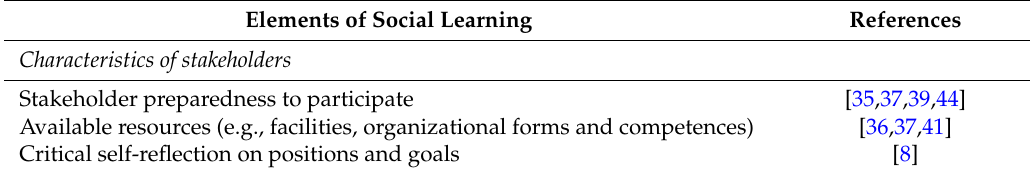
Table 1. Key elements of social learning